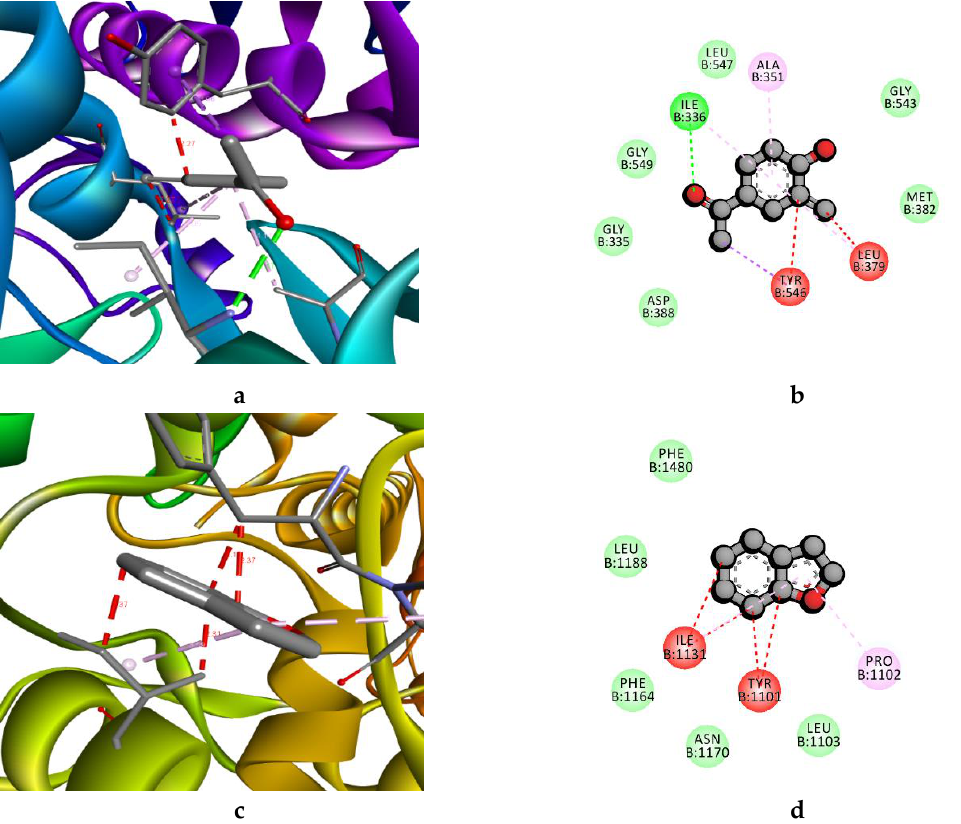
Figure 2. Docking analysis; ( a , b ). Three-dimensional (3D) and two-dimensional (2D) structures of the interactions between 2-Methoxy-4-vinylphenol and LpxC, respectively, and ( c , d ). The 3D and 2D structures of the interactions between benzofuran and 4PLB,